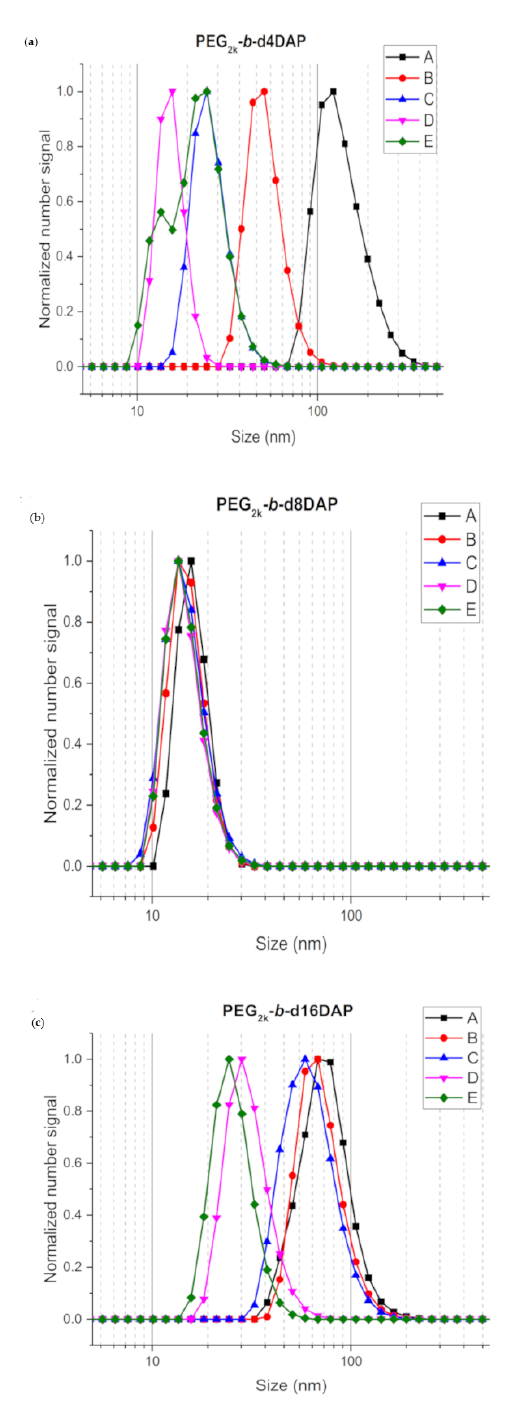
Figure 3. Number size distributions recorded by DLS of PEG 2k - b -dxDAP self-assemblies prepared by microfluidics at different experimental conditions (aqueous/organic phase ratio) according to Table 3: A (60/40), B (70/30), C (80/20), D (90/10), and E (95/5): ( a ) PEG 2k - b -d4DAP , ( b ) PEG 2k - b -d8DAP and ( c ) PEG 2k - b